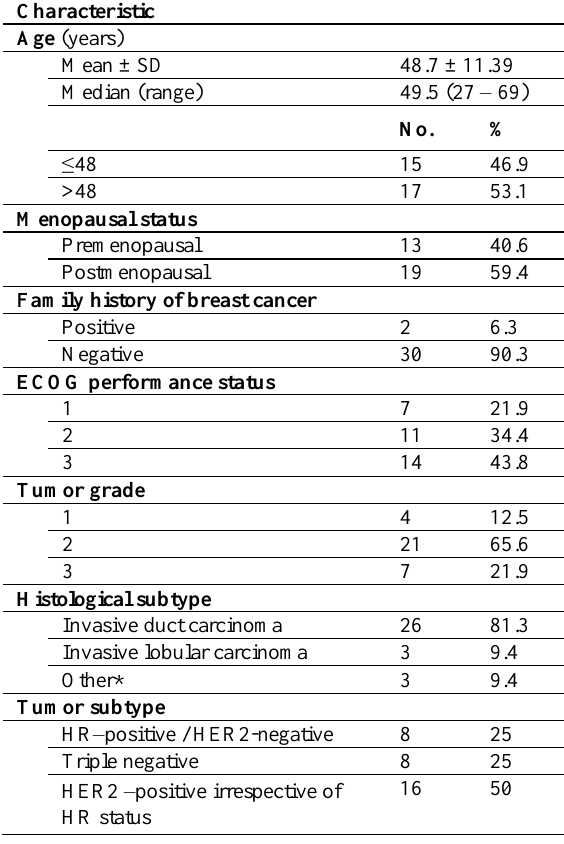
Table 1: Personal and tumor characteristics of 32 patients at the time of diagnosis of brain metastases